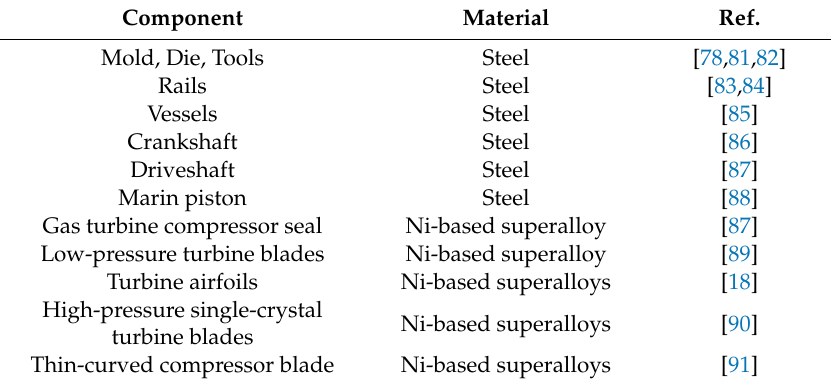
Table 4. Application of DED in repairing the various components.